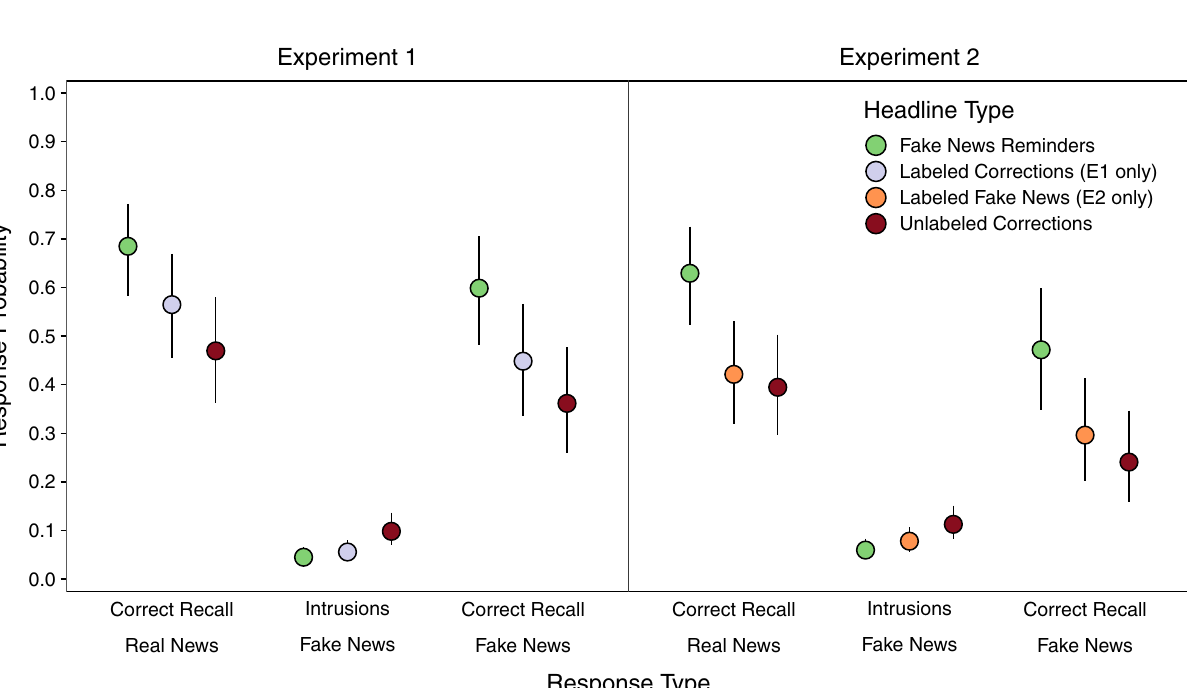
Figure 2. Probabilities of real news recall, intrusions of fake news, and fake news recall in Phase 3 for each correction headline type condition. Points are probabilities estimated from mixed effects models; error bars are 95% confidence